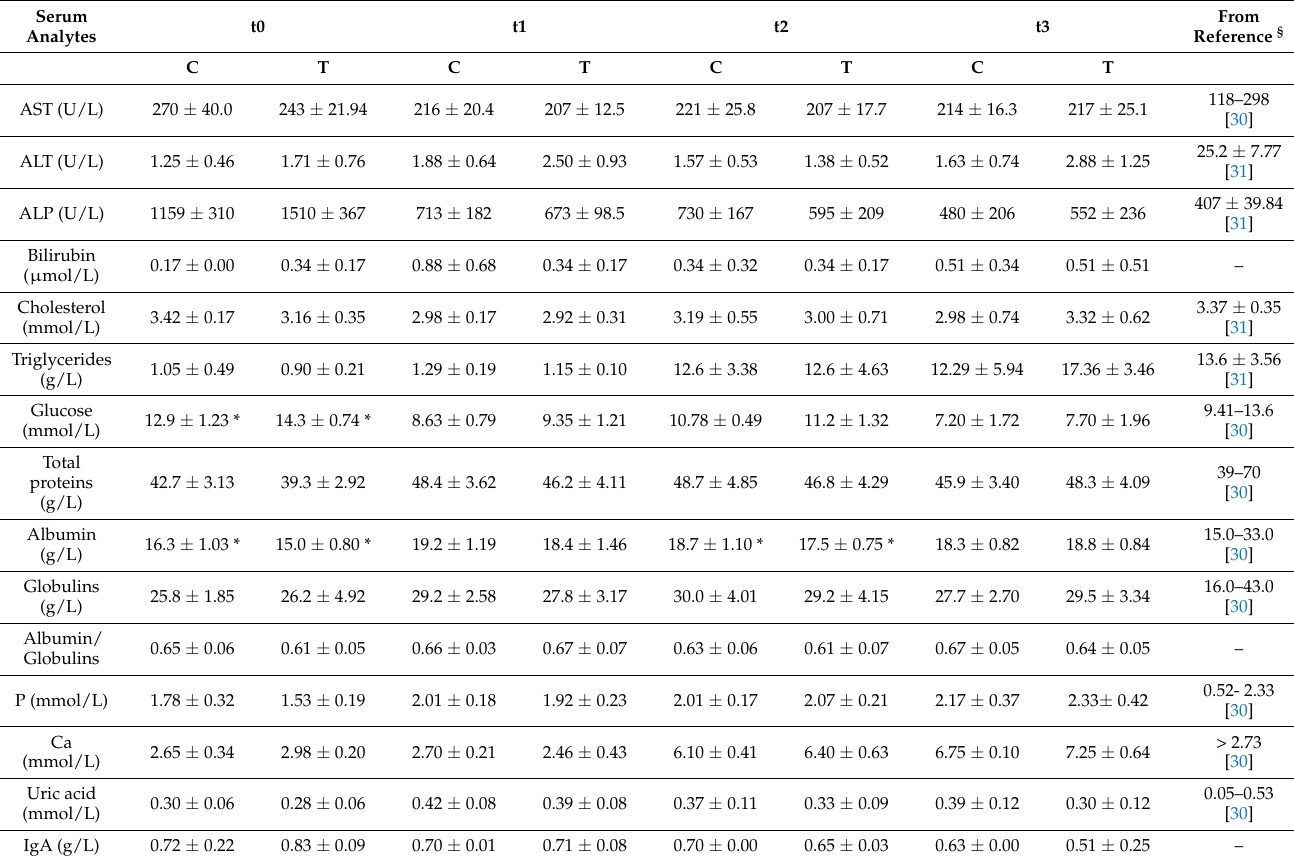
Table 3. Serum biochemical analytes in Leghorn hens. Data are reported as mean ± SD ( n = 8 for each group and at each. Timepoint: at the start of the trial (t0), after 5 weeks of supplementation (t1), at the end of supplementation (t2—12 weeks) and at the end of the trial (t3—19